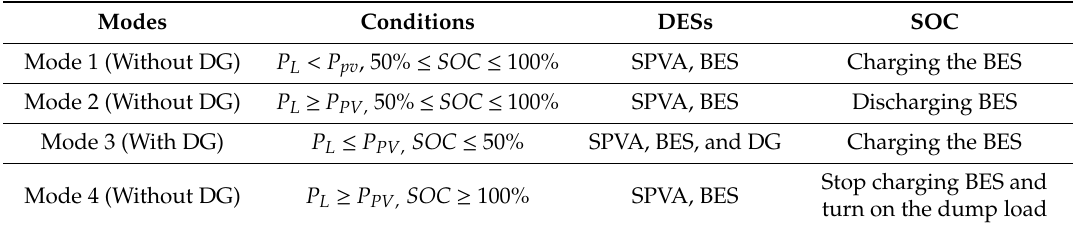
Table 2. Operation modes for off-grid configuration based on SPVA and DG.